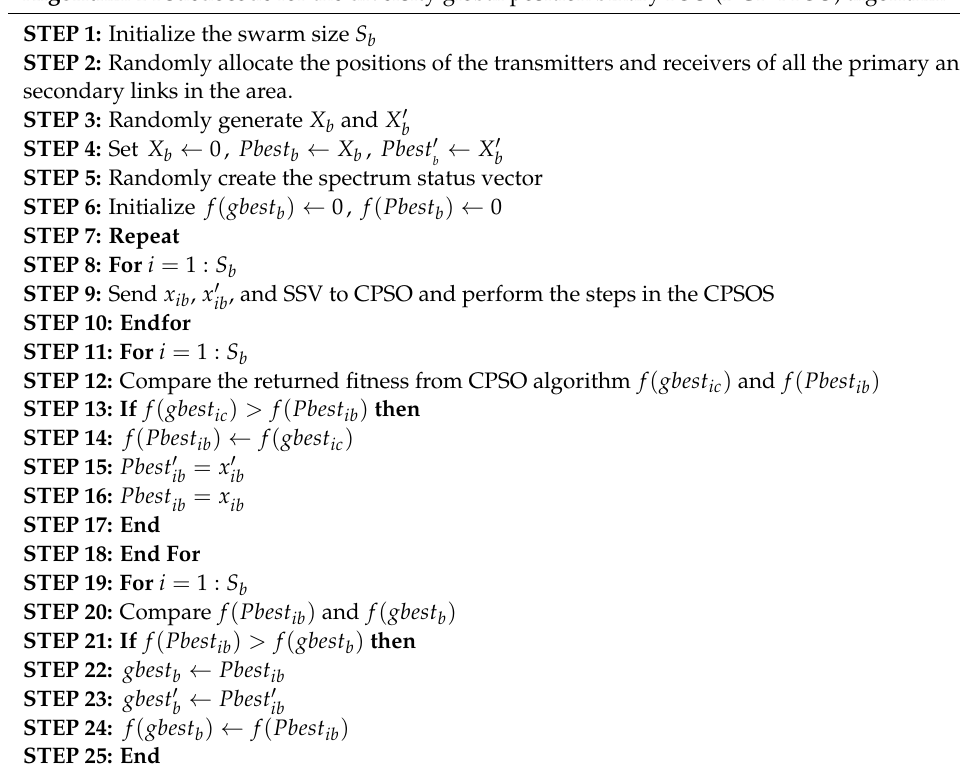
Algorithm 1 Psuedocode for the diversity global position binary PSO (DGP-BPSO)